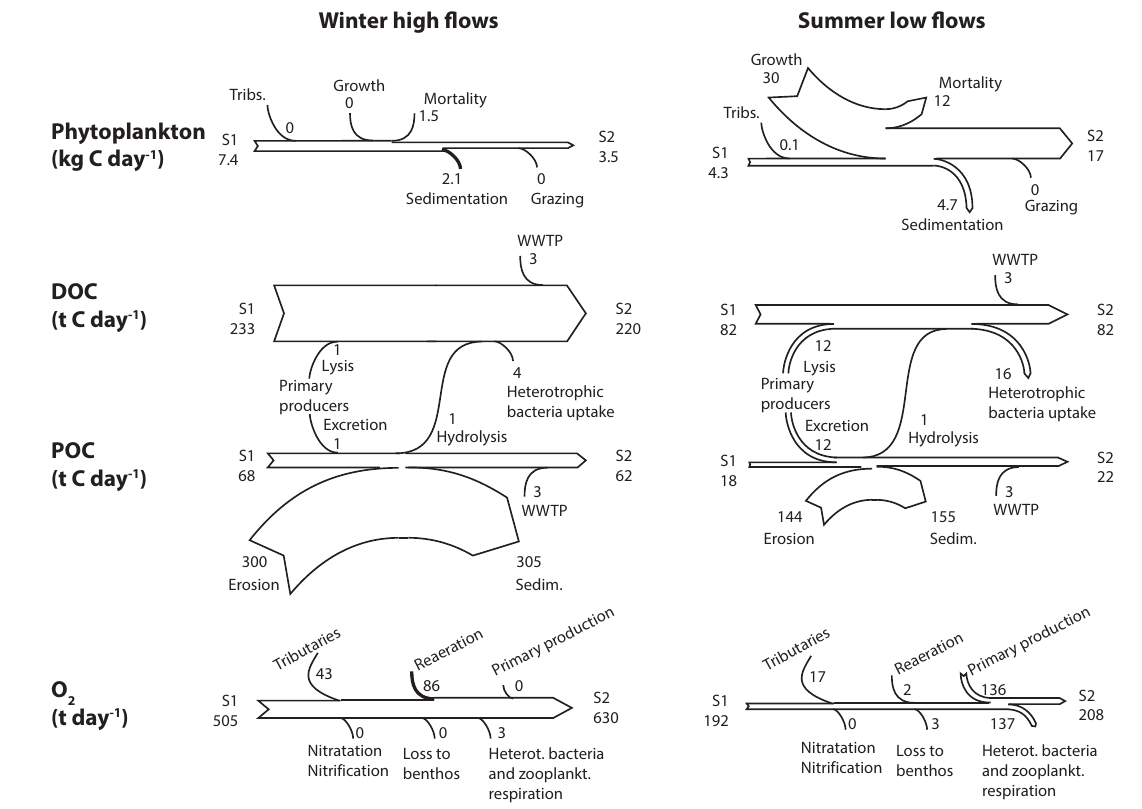
Figure 8. Average winter and summer budgets between S1 and S2 for phytoplankton biomass, dissolved and particulate organic carbon, and dissolved oxygen. All arrows widths are proportional to calculated fluxes, allowing the visual comparison between winter and summer